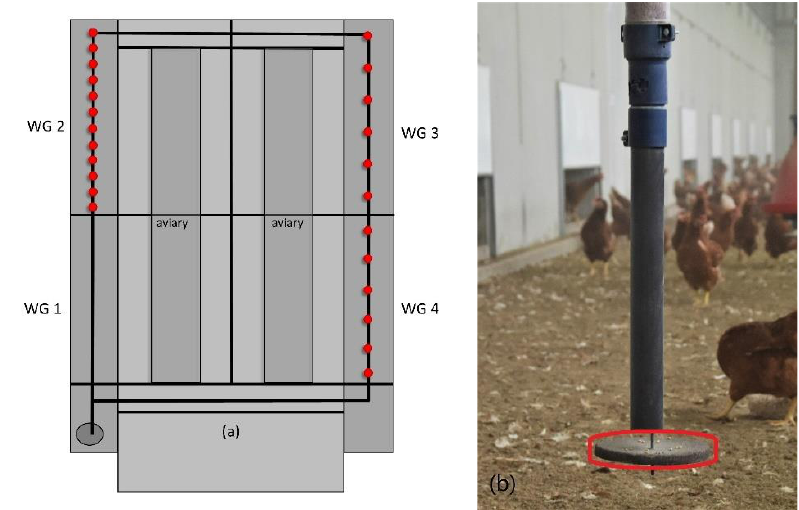
Figure 1. ( a ) Scheme of the henhouse and winter gardens (WGs 1–4) with the downpipes with pecking plates indicated with red dots; ( b ) photograph of the enrichment device with the pecking plate circled in red (photo: A. Riedel). Adapted from [25].